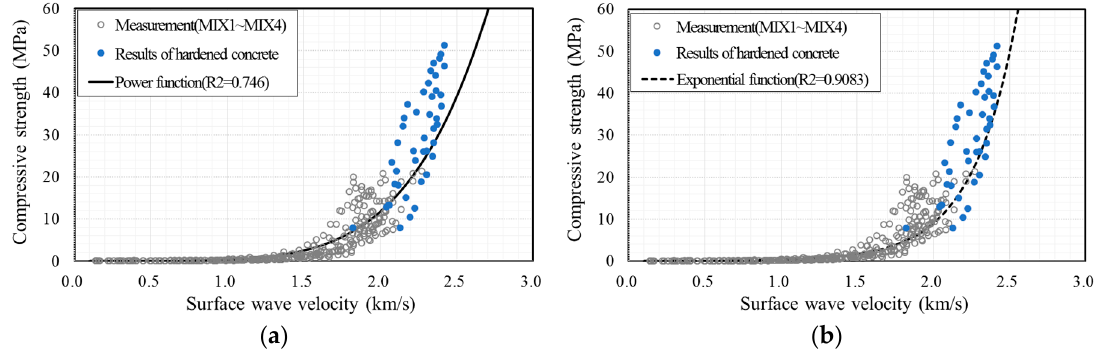
Figure 11. Compressive strength of concrete vs. surface wave velocity: experimental data fitted by ( a ) the power function of Equation (3) with a = 0.2813 and b = 5.3814 and ( b ) the exponential function of Equation (4) with a = 0.0098 and b = 3.412.